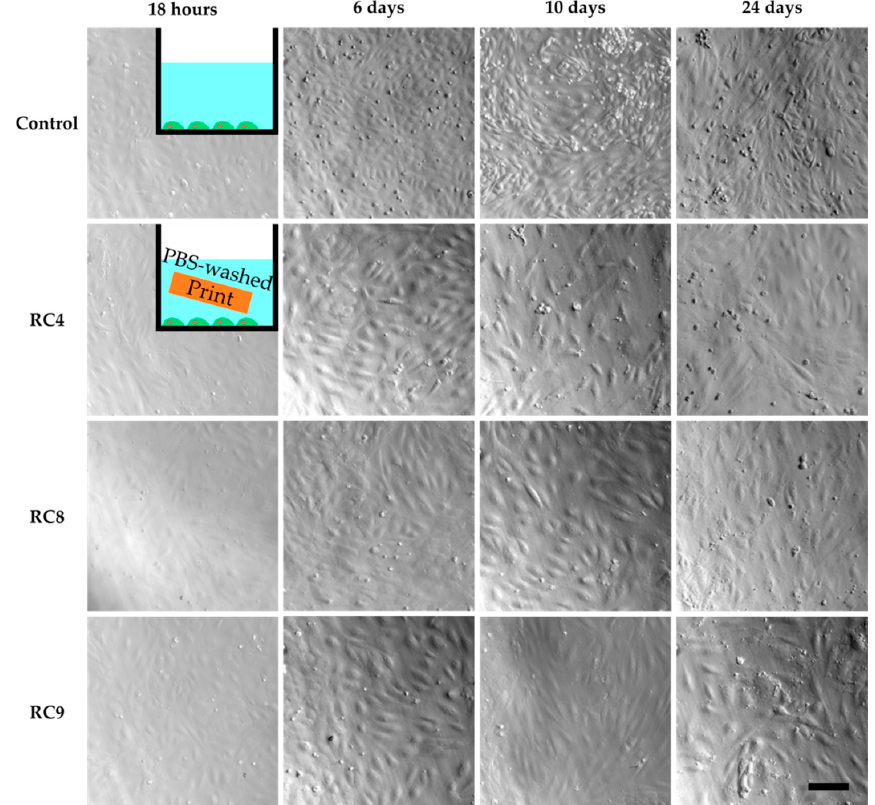
Figure 3. HUVECs cultivated in PS 48-wells for 24 days, with images taken after 18 h, 6 days, 10 days and 24 days to study cell viability. The first image row shows the control experiment without the presence of any 3D-printed parts in the cell culture media. Row two to four show images of HUVECs exposed to 3D-printed parts made from RC4, RC8, and RC9, respectively. The HUVECs adhere to the PS surface, spread, and are viable as seen from 18 h to 24 days. In addition, the cell density is similar to the control. The scale bar denotes 200 µm for all samples.